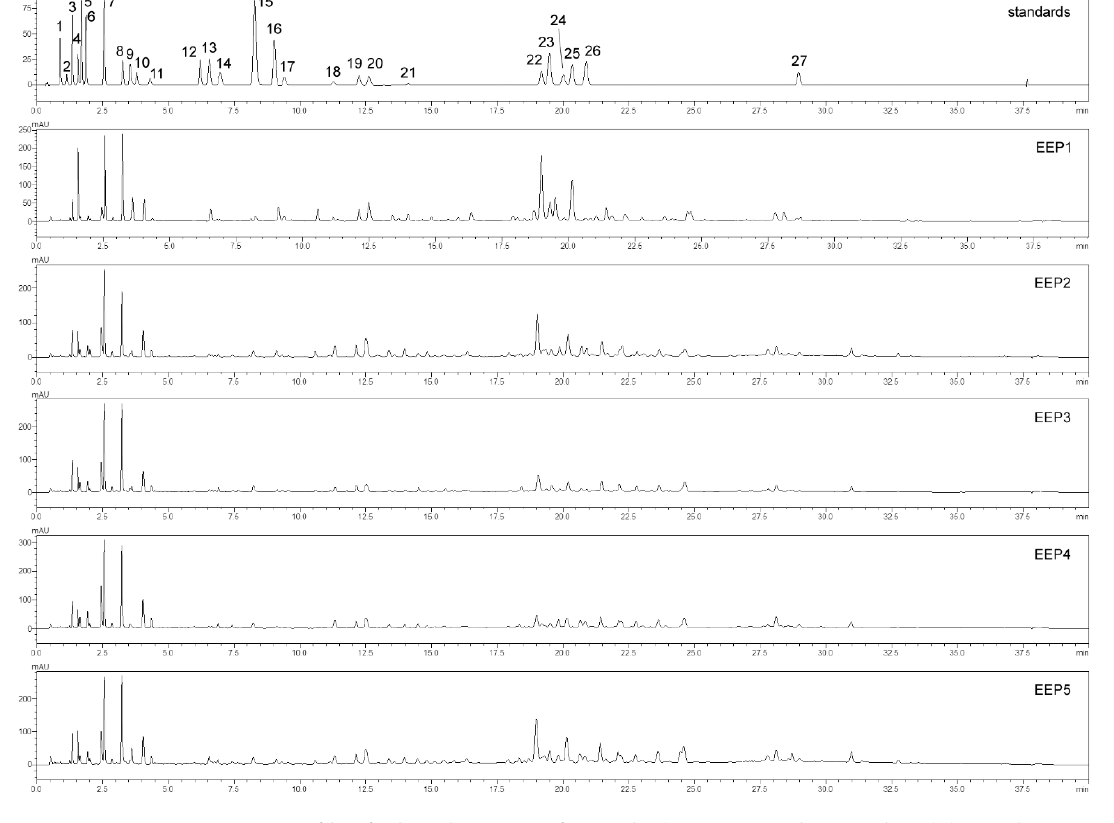
Figure 1. HPLC-DAD profile of ethanol extracts of propolis (1:protocatechuic acid, 2:(+)-catechin, 3:4-